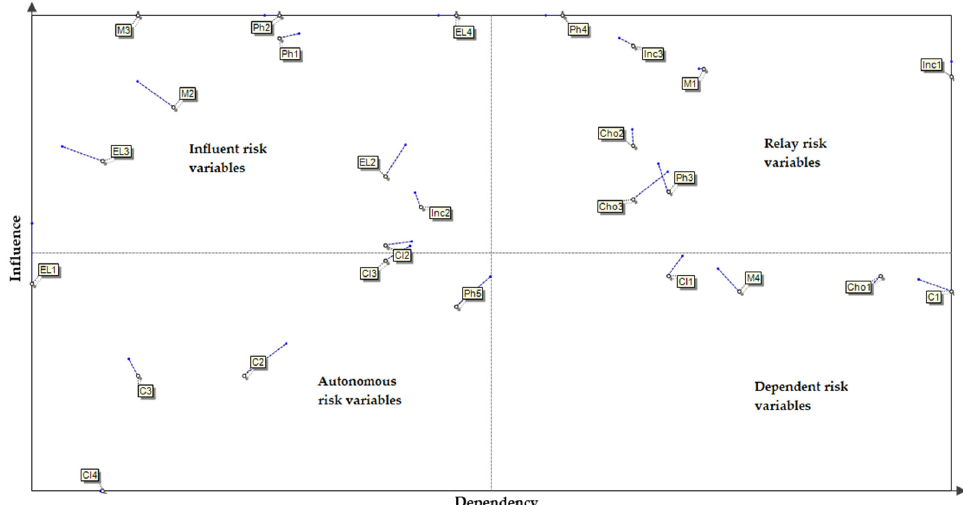
Figure 3. The direct and indirect displacement map.